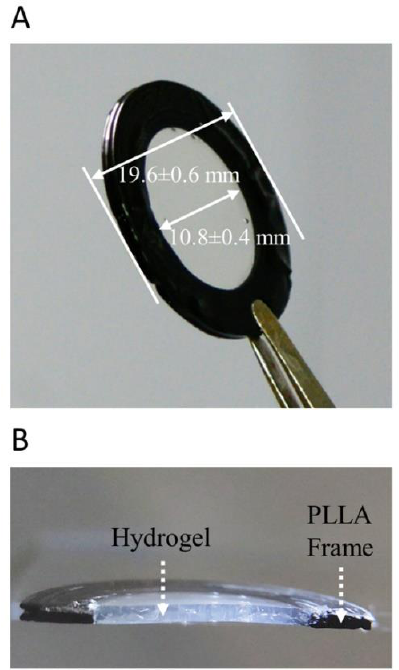
Figure 1. Collagen hydrogel casted onto a plastic circular supporting frame made from poly-L-lactic acid (PLLA, seen as black ring) designed to support the formation of a human corneal epithelial multilayer for drug permeability testing in a vertical chamber ( A ). Cross-section of the transparent hydrogel/plastic supporting frame ( B